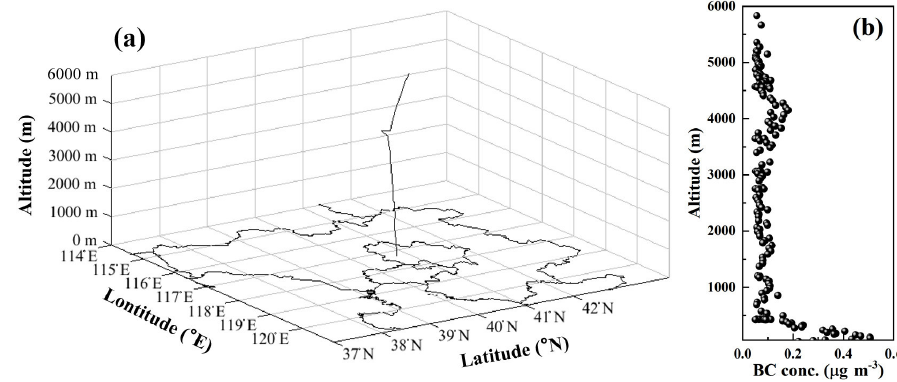
Figure 3. (a) Aircraft routes and (b) the BC profile observed at 10:00–11:00BJT.